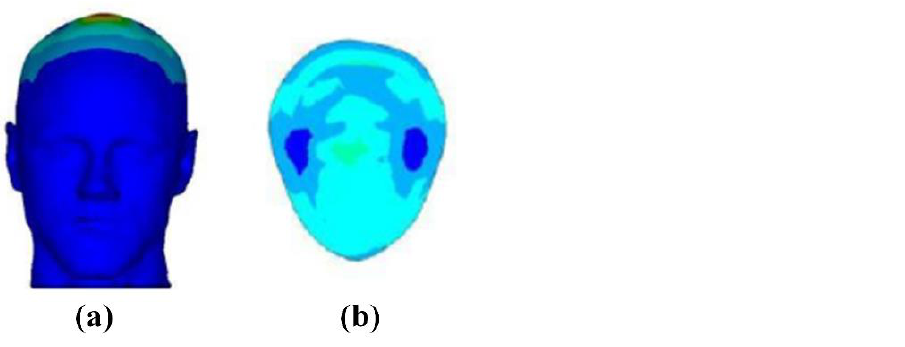
Figure 7. Magnetic field distribution stimulated by TMS. ( a ) Front view of the induced electric field distribution on the scalp surface. ( b ) Sectional view of the x-y plane.